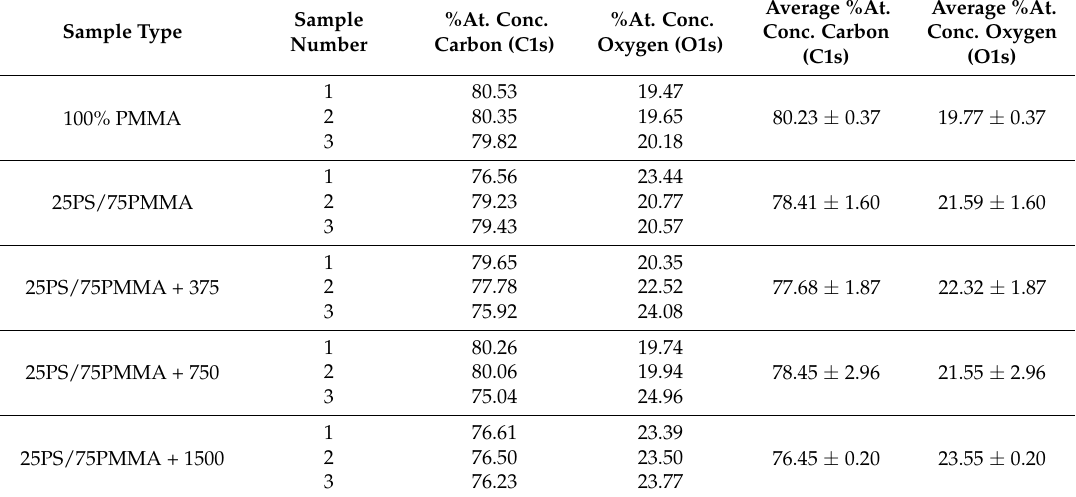
Table 1. XPS quantitative data (% atomic concentration ( n = 3)) for O1s and C1s contributions to 25PS/75PMMA demixed spin coated surfaces with and without addition of 375, 750 and 1500 50 µ m PS microspheres. Data for a spin coated 100% PMMA film is included for comparison.